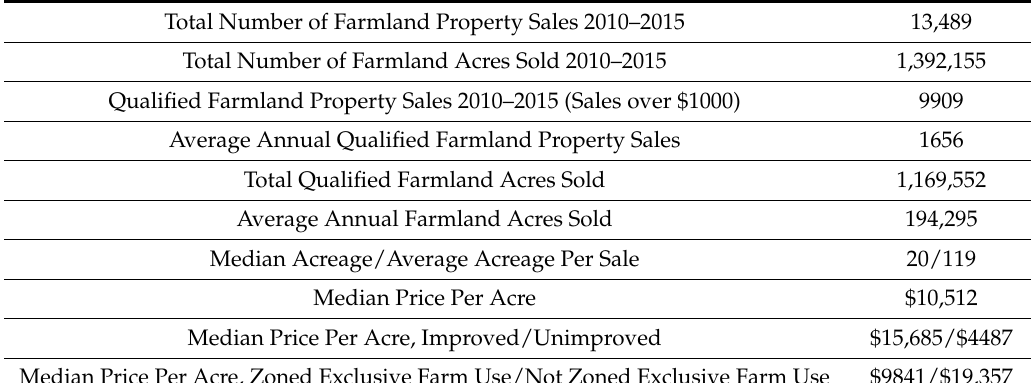
Table 1. Oregon region farmland sales